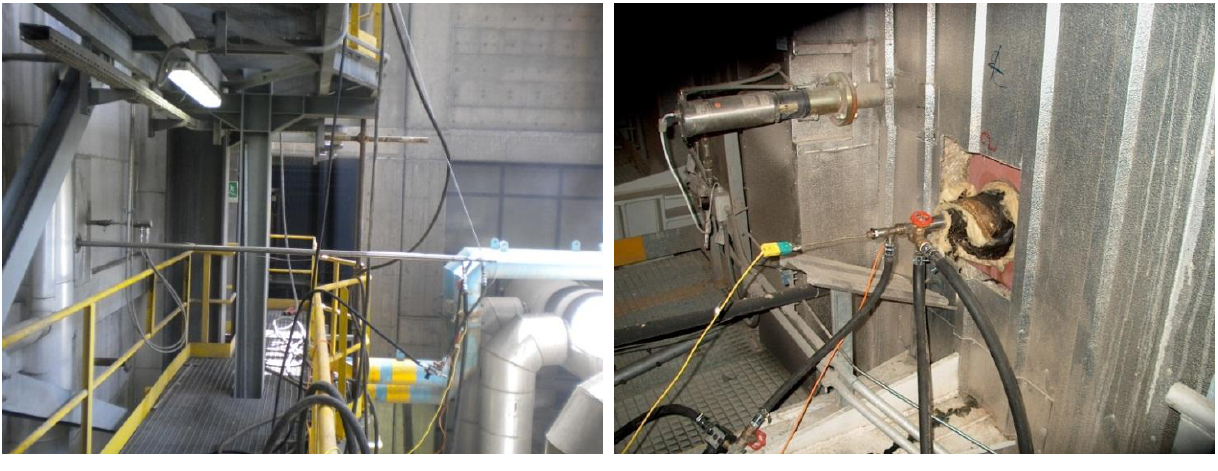
Figure 6. Suction pyrometer used for the in situ calibration of a thermocouple and an IR